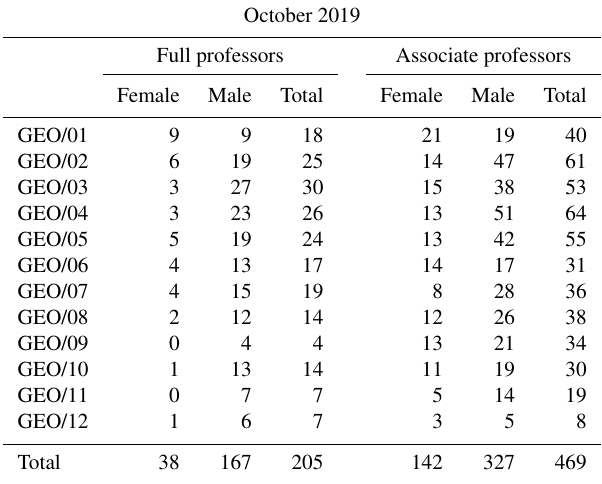
Table 4. Number of full and associate professors in all GEO scien- tific SSD (from 01 to 12) of the Italian university system relative to October 2019 (data source: MIUR, https://cercauniversita.cineca.it/ php5/docenti/cerca.php, last access: 31 October